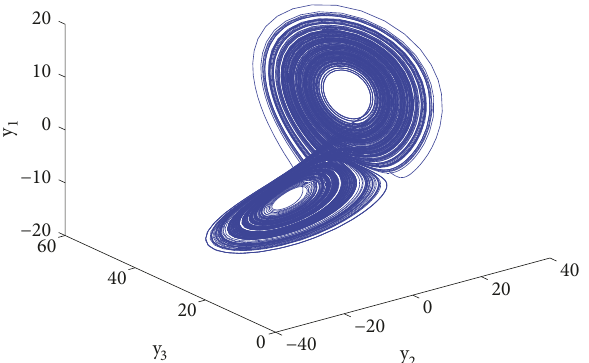
Figure 6: The chaos attractor of fractional-order modified unified chaotic system with (𝑦 1 (0),𝑦 2 (0),𝑦 3 (0)) = (2,−1.5, 5) .